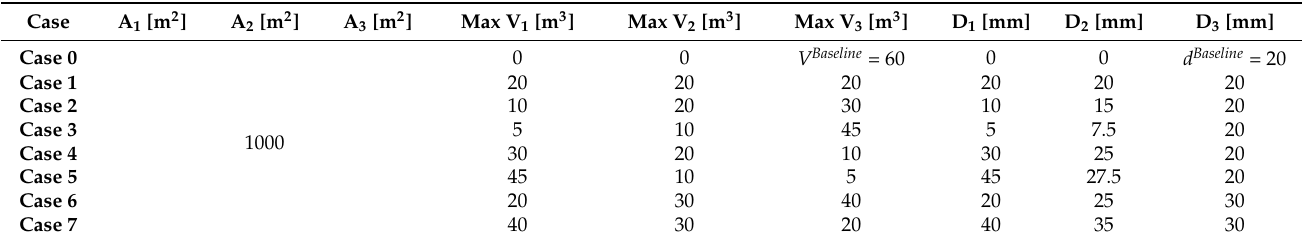
Table 1. Data for modelling the different cases.